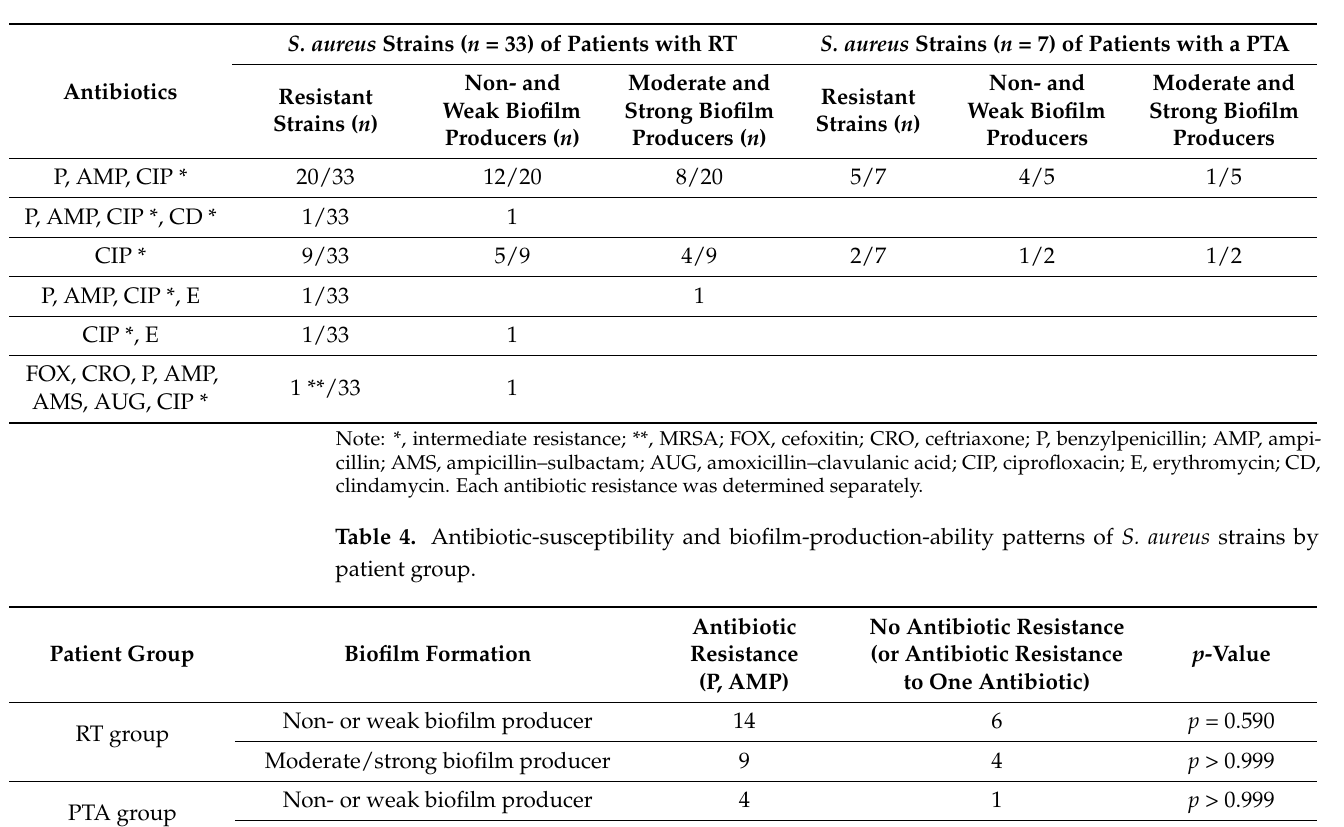
Table 3. Antibiotic-susceptibility and biofilm-production-ability patterns of S. aureus strains.